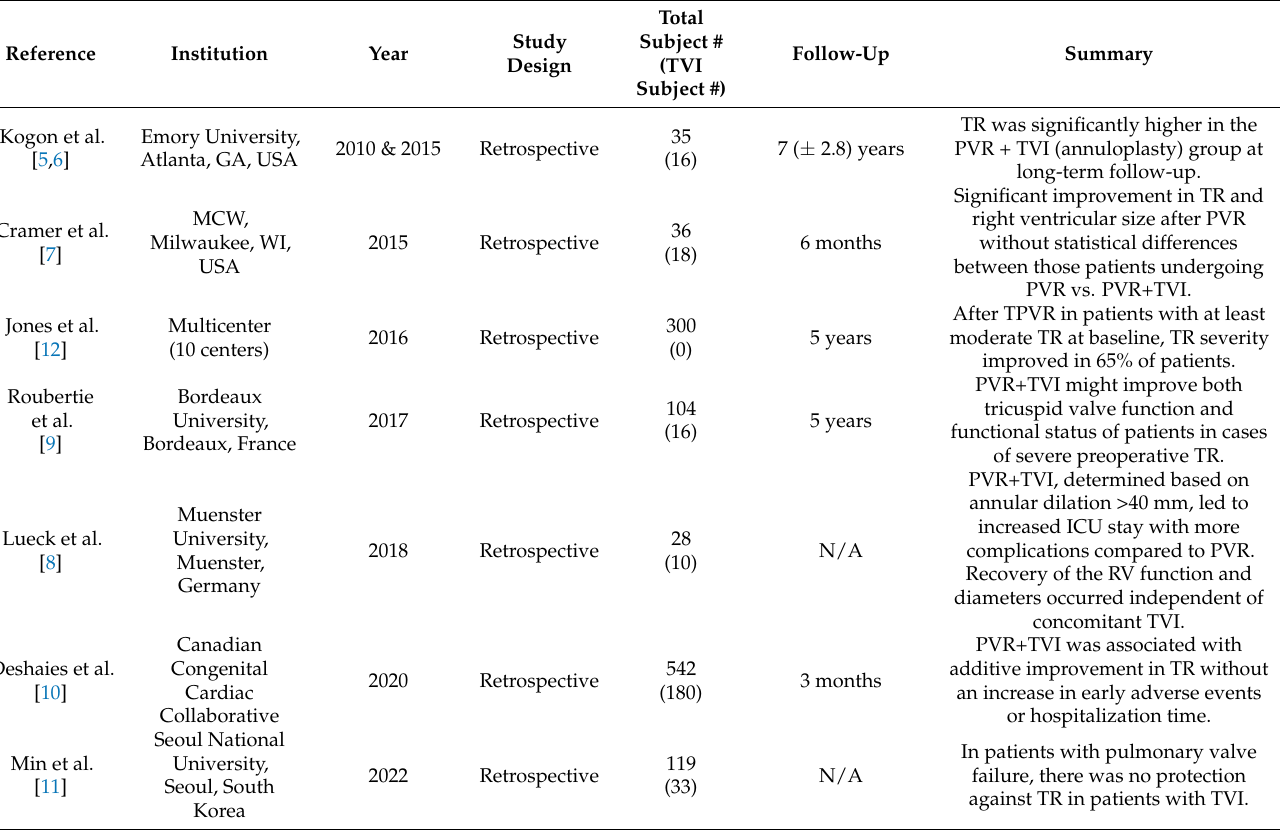
Table 1. Studies comparing pulmonary valve replacement alone vs. pulmonary valve with concomi- tant tricuspid valve intervention in